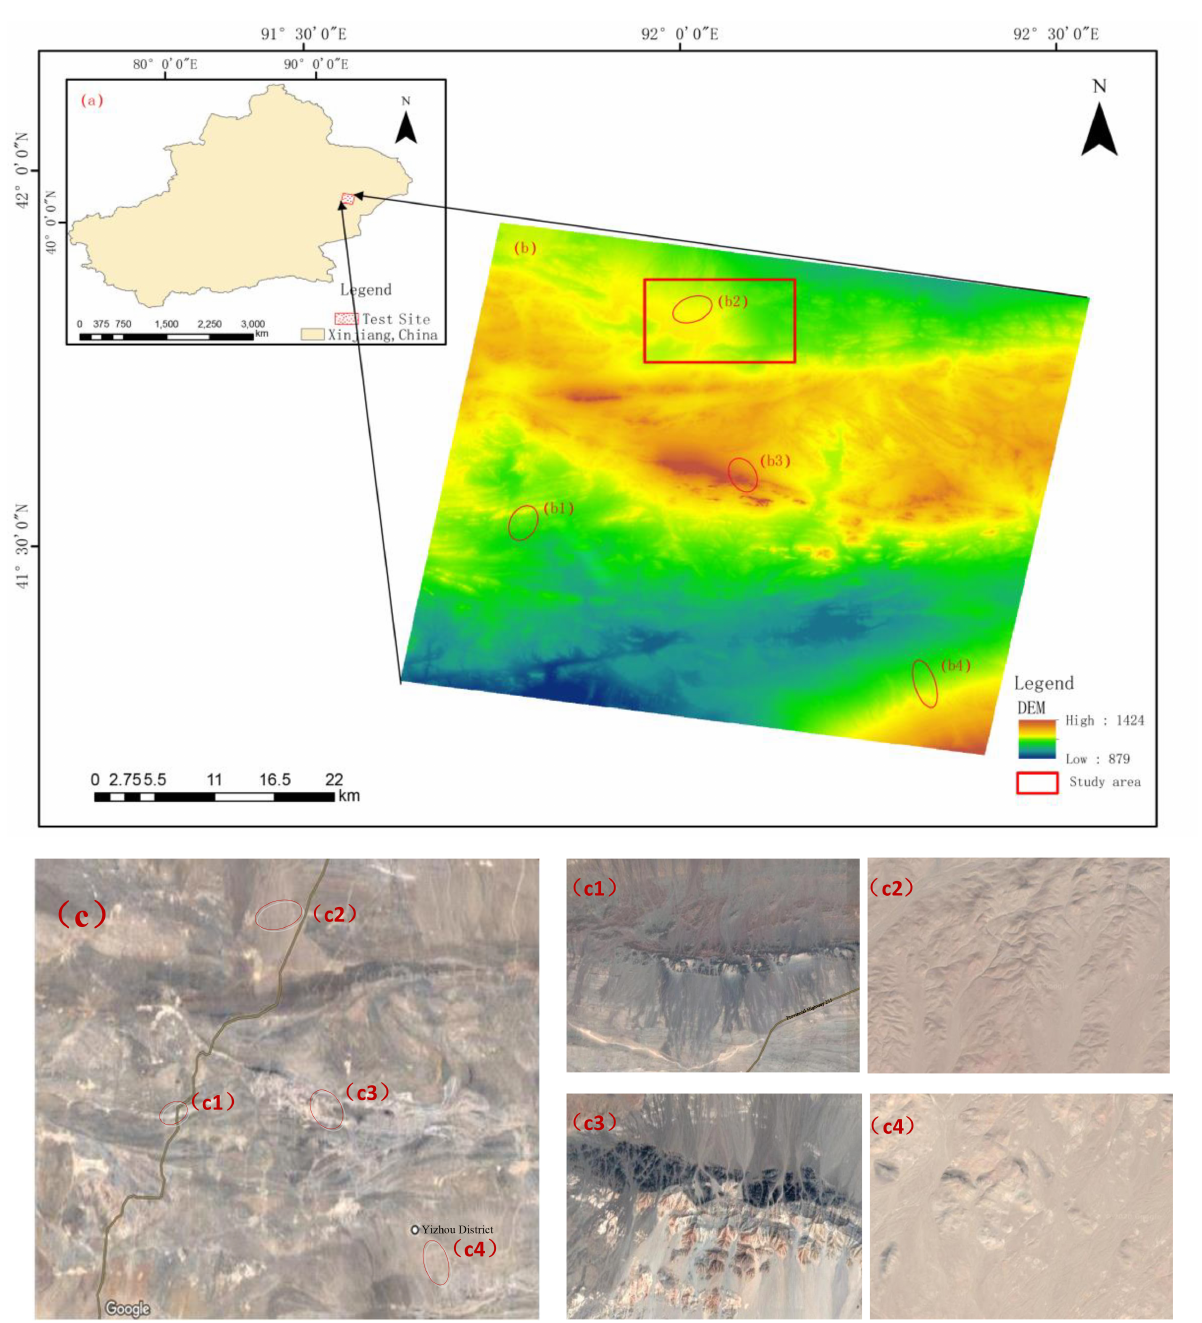
Figure 4. Location of the test site and study area. ( a ) Xingjiang, China. ( b ) Test site’s DEM. ( b1 , b3 ) shows exposed rocks and rocks covered by shallow sand, ( b2 , b4 ) are covered by uniform sand. ( c ) Test site’s optical image from Google earth. ( c1 – c4 ) show the geomorphic features correspond to ( b1 – b4 ),